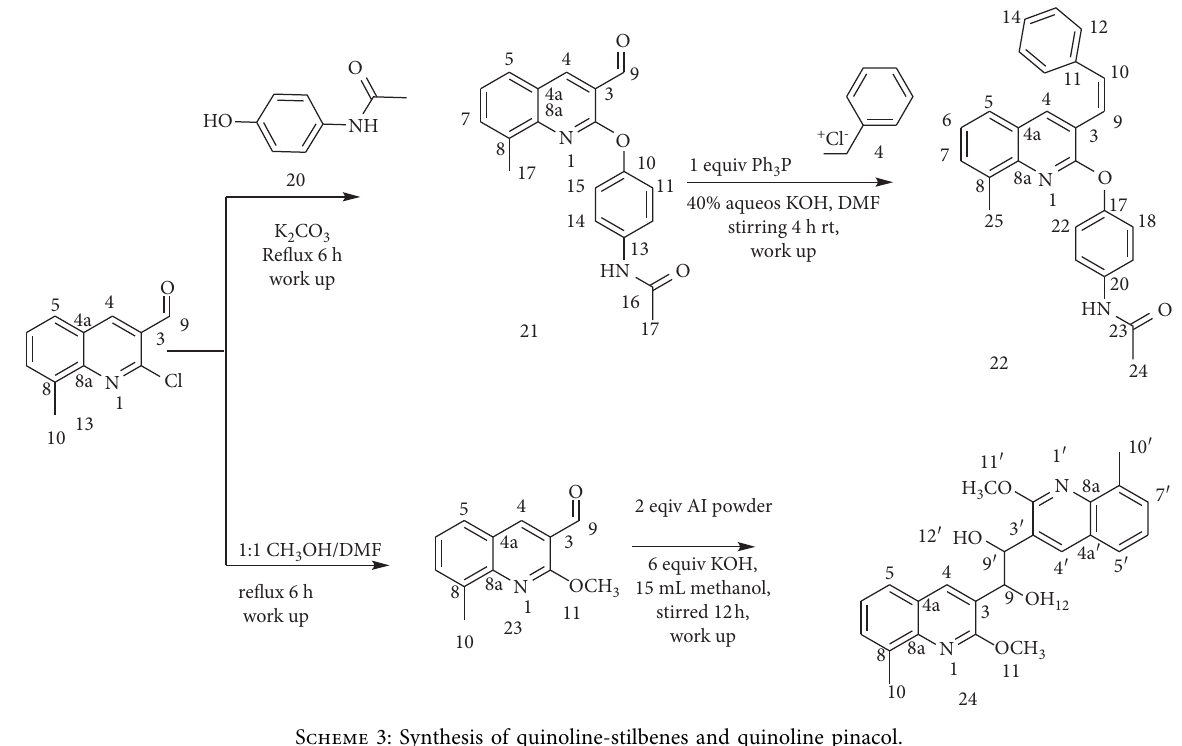
Scheme 3: Synthesis of quinoline-stilbenes and quinoline